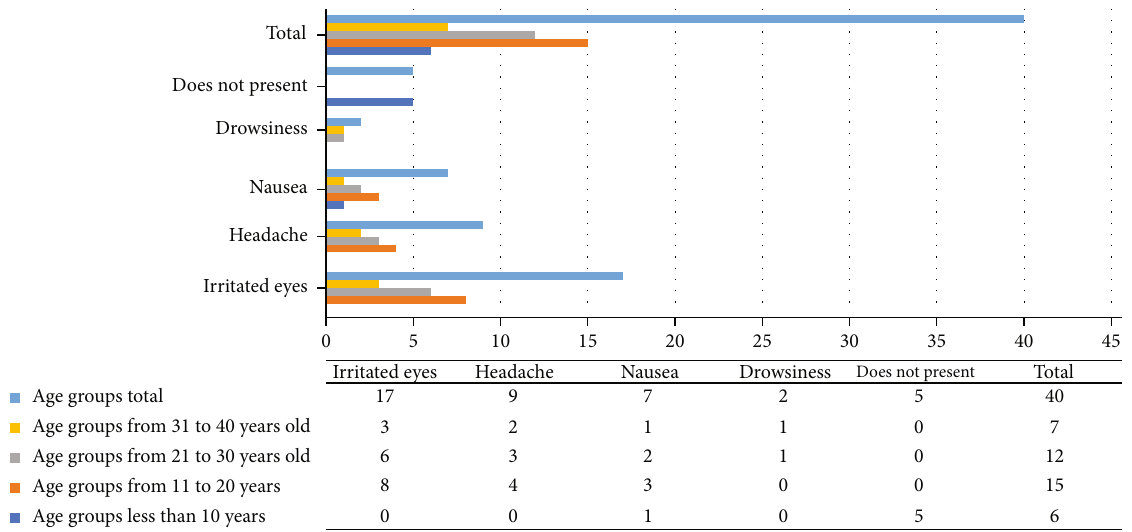
Figure 6: Result of signs or symptoms found in relation to years of